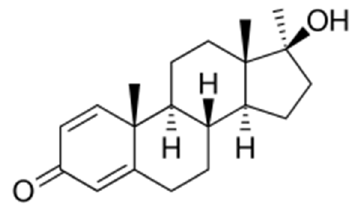
Figure 28. Chemical structure of methandienone. Formula: C 20 H 28 O 2.